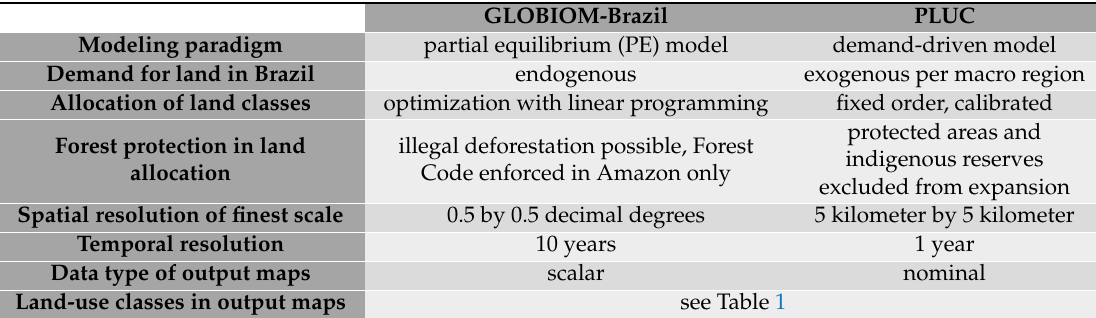
Figure 2. Temporal extent and resolution of GLOBIOM-Brazil, PLUC, and the coupled model. Each black dot surrounded by a circle is an initial land use map (model input); each single black dot represents a model output. The black box indicates the validation period. Table 2. Overview of the methodological di ff erences between the two models that are coupled to each other: GLOBIOM-Brazil and PLUC.